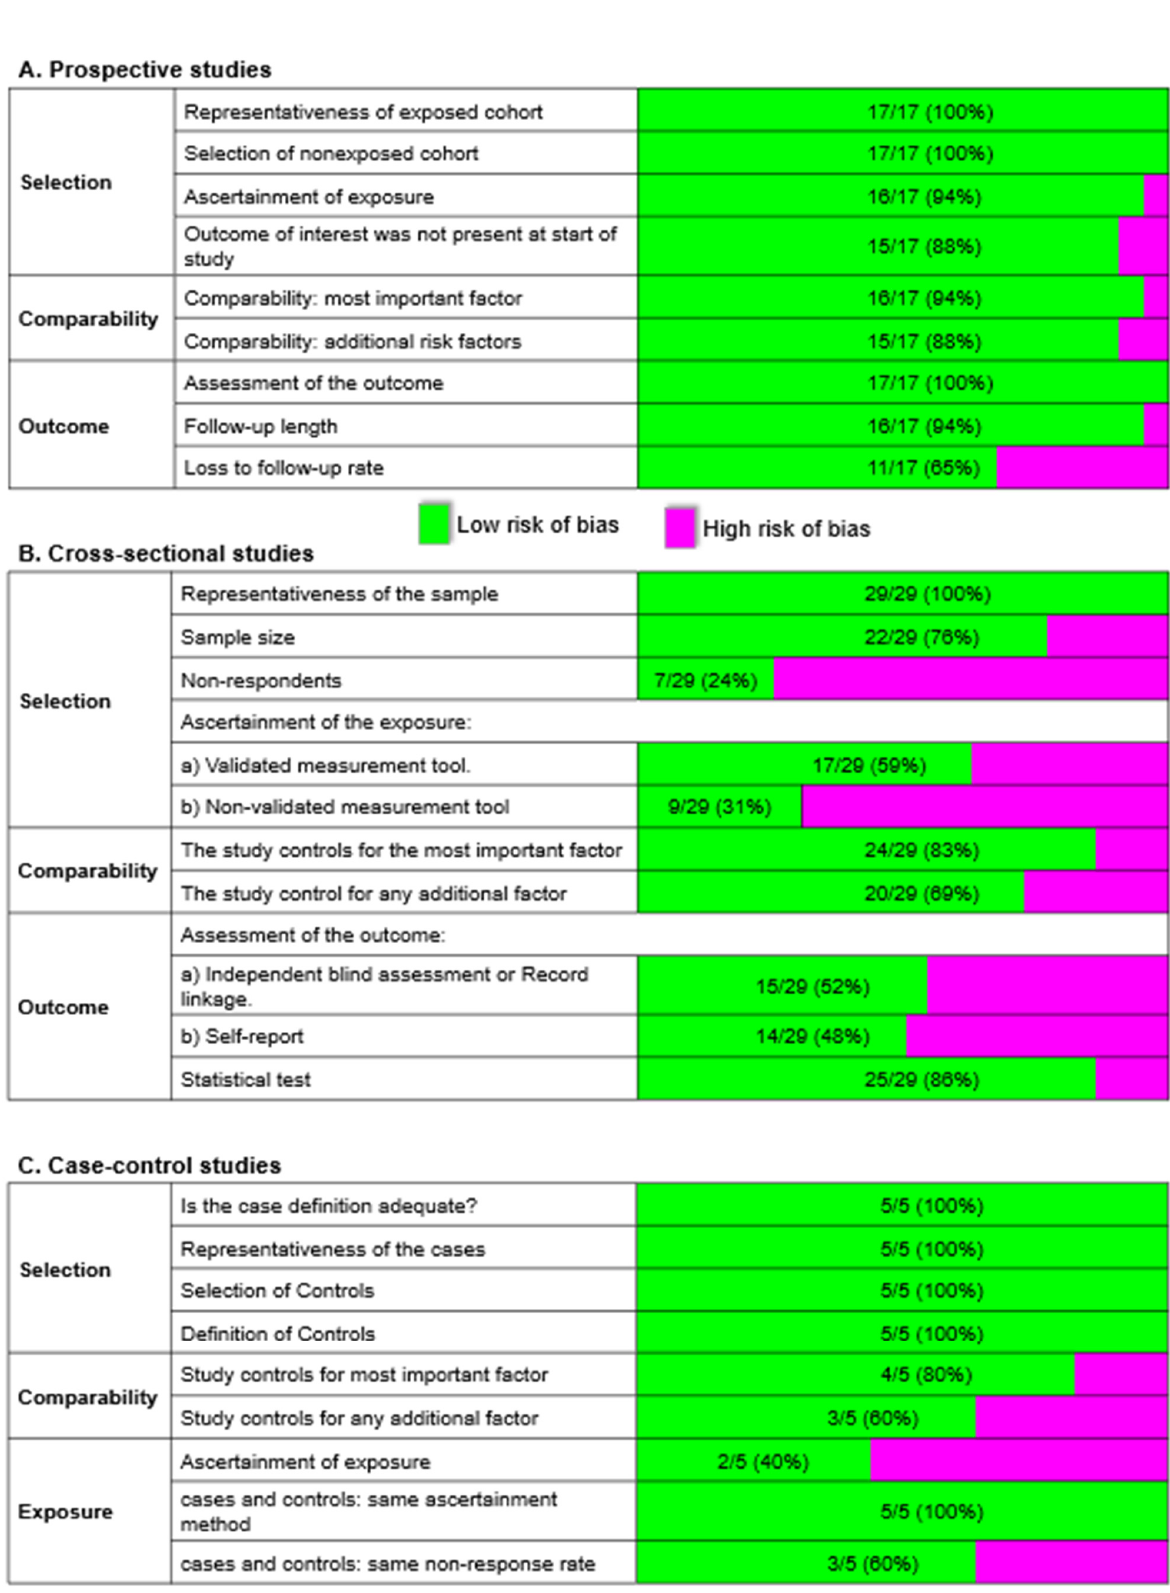
Figure 4. Risk of bias by the domain (in bold) and specific regions in ( A ) 17 prospective, ( B ) 29 cross- sectional, and ( C ) 5 case–control studies using the Newcastle–Ottawa Scale. Numbers on the green bar represent the number of studies with a low risk of bias over the number of studies assessed.